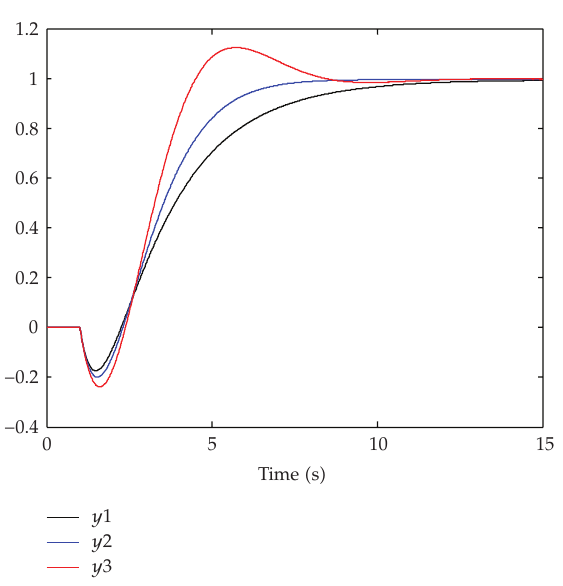
Figure 6: The influence of the length of spectral